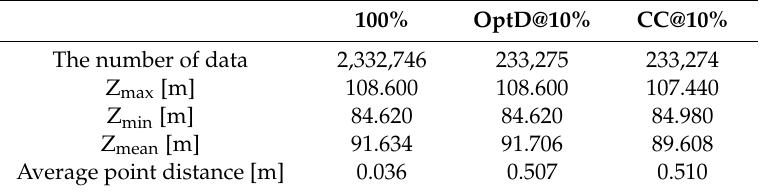
Table 2. Characteristics of the ALS dataset before and after data reduction.